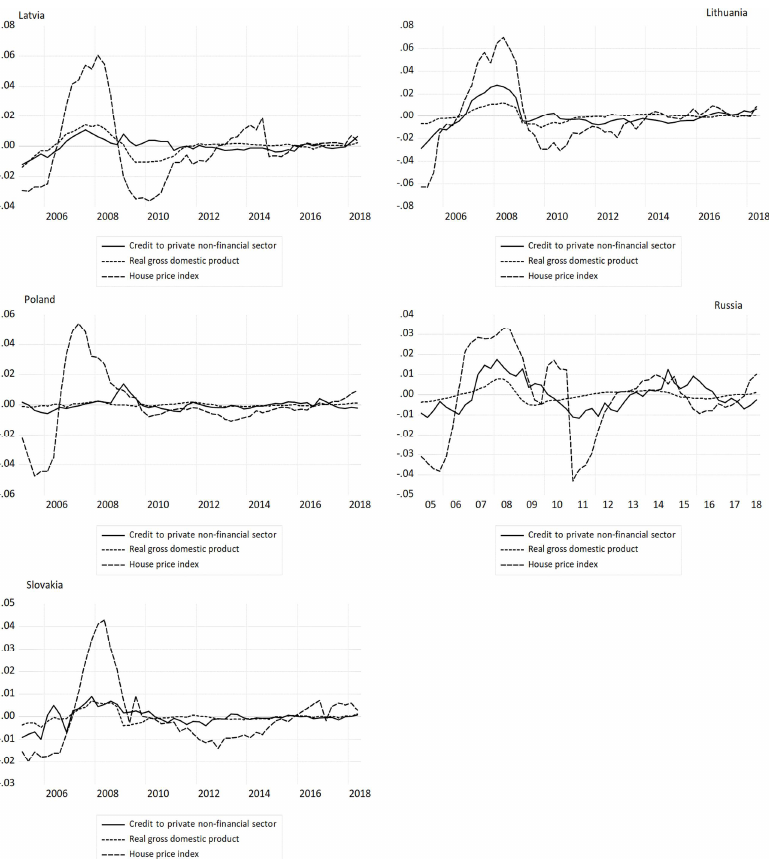
Figure 2. Extracted Cyclical Components of Credit to Private